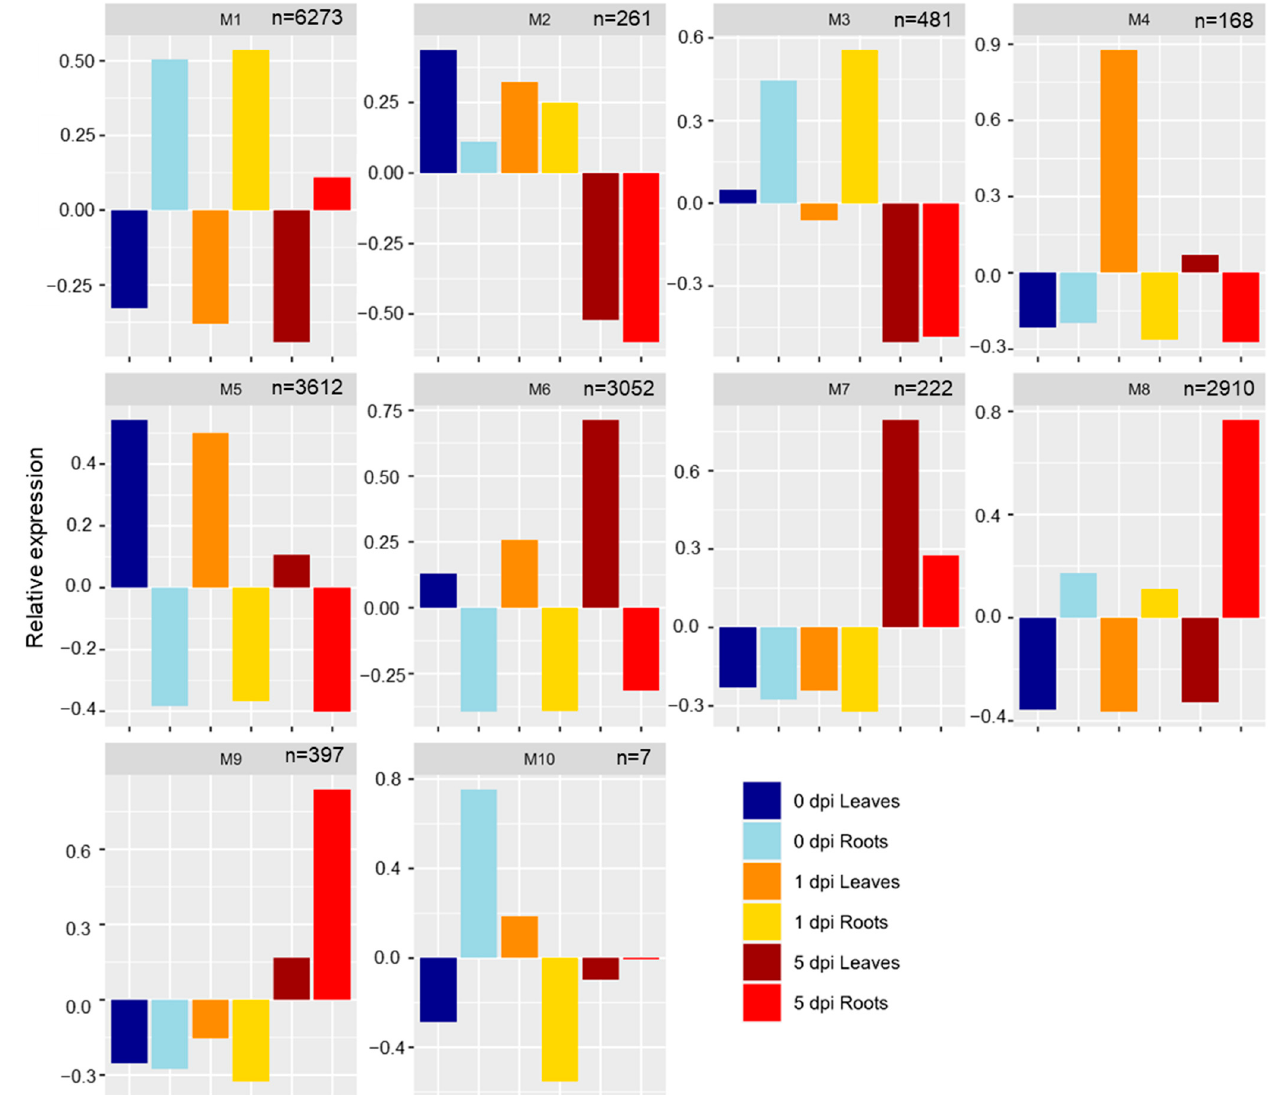
Figure 4. Weighted gene co-expression network analysis (WGCNA) of the 17,383 differentially ex- pressed genes (DEGs). Barplots represent the expression pattern of the genes assigned into 10 co- expression modules (M1-10). n indicates the number of DEGs in each WGCNA